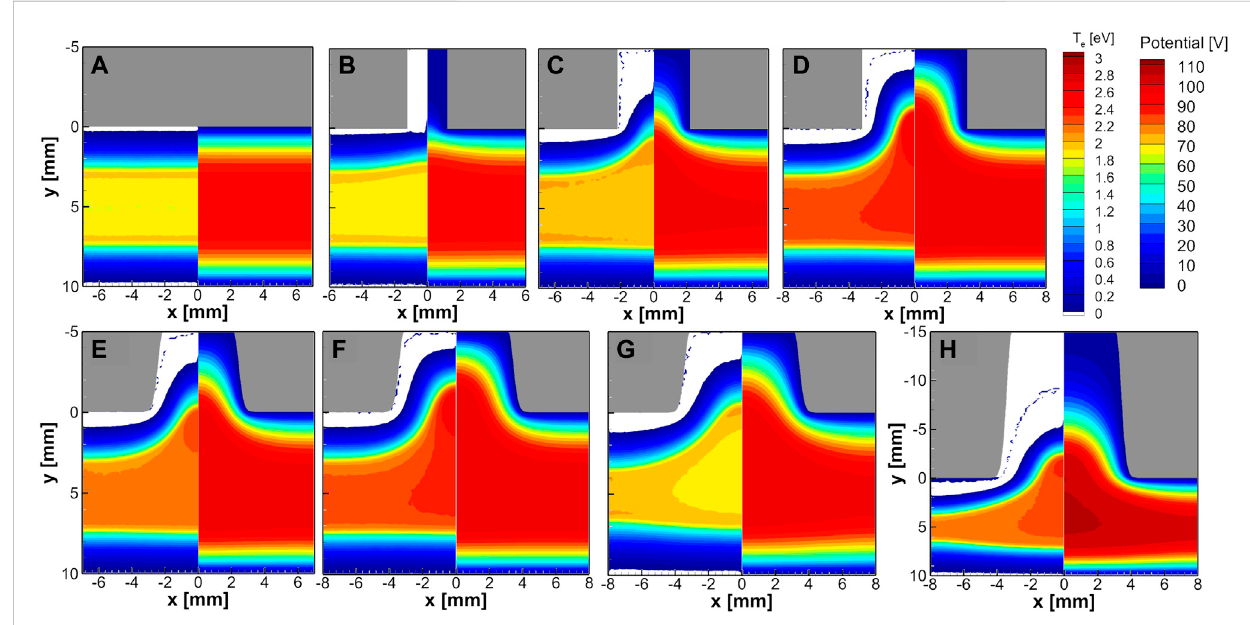
FIGURE 4 The time-averaged spatial pro fi les of the electron temperature (left side) and the electric potential (right side) obtained by changing the simulation conditions (A) withouttrenchorwithaninlettrenchsizeof (B) d =2 mm, (C) d =4 mm,and (D) d =6 mm, (E) d =4 mmwithGaussianshapeslope, (F) d =